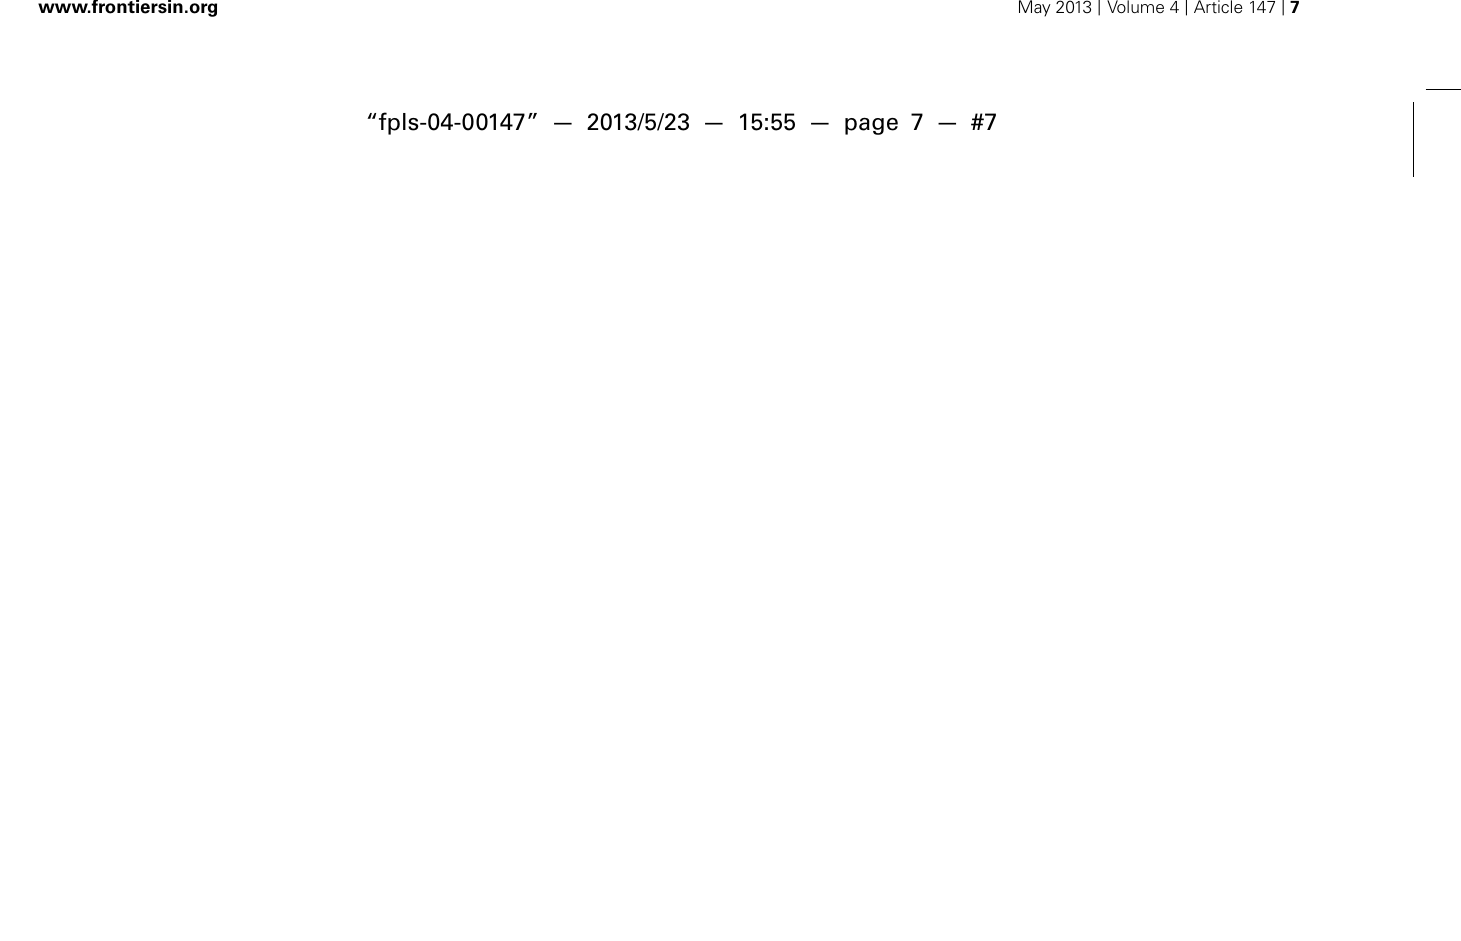
been reported to lead to the LSE phenotype in Arabidopsis (SEX1; Caspar et al., 1991), L. japonicus (Vriet et al., 2010), and